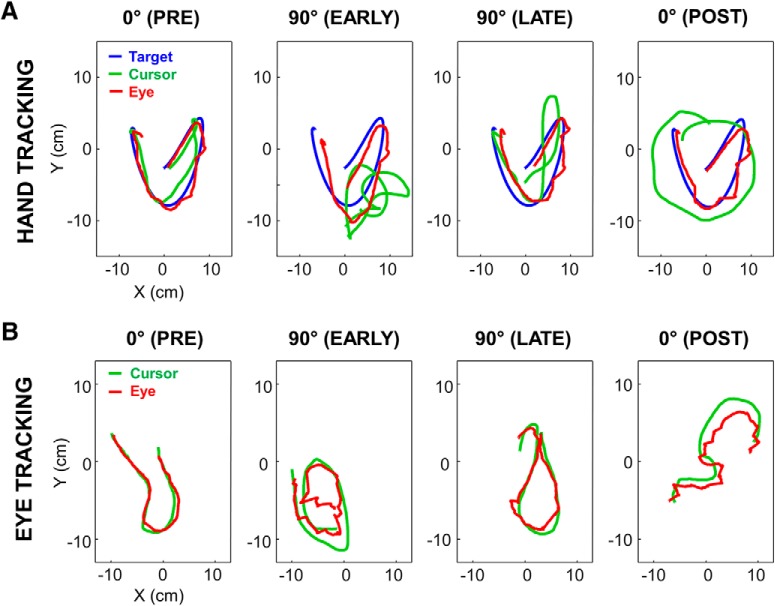
Typical trials under each experimental condition at various moments. A, Target, cursor, and eye position signals in the hand tracking task, during pre-exposure, early exposure, late exposure, and after exposure to the 90° visuomotor rotation. B, Same as A for eye and cursor position signals in the eye tracking task. Trials presented on the top and bottom rows were performed by two distinct participants. Although each trial was 10 s long, only 2.5 s of signals are displayed for clarity.